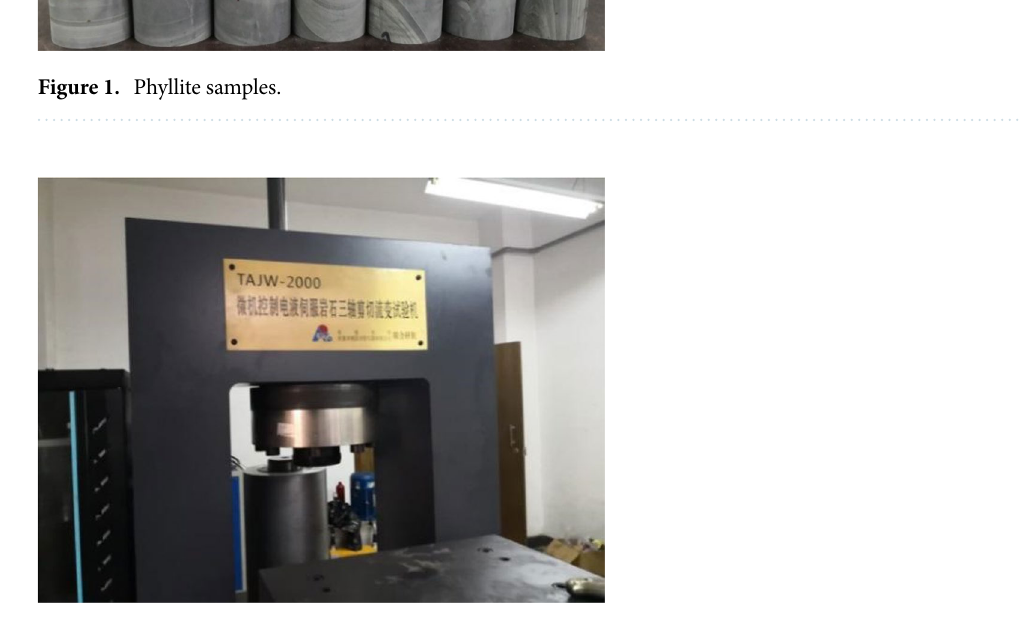
Figure 2. TAJW-2000 triaxial shear